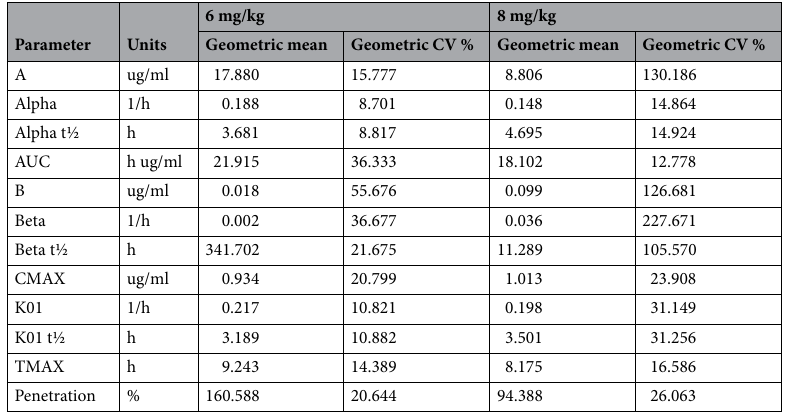
Table 2. Pharmacokinetic parameters for danofloxacin in interstitial fluid (ISF) dosed at 6 mg/kg under the skin every 48 h for two doses and 8 mg/kg under the skin once. A, B, the intercept for the initial and terminal portions of the curve, respectively. Alpha (α) and beta (β) are the rate constants for the initial and terminal portions of the curves, with their respective half-lives (t½). K01 is the absorption rate and corresponding half- life (t½). C MAX maximum drug concentration, T MAX time to maximum drug concentration.